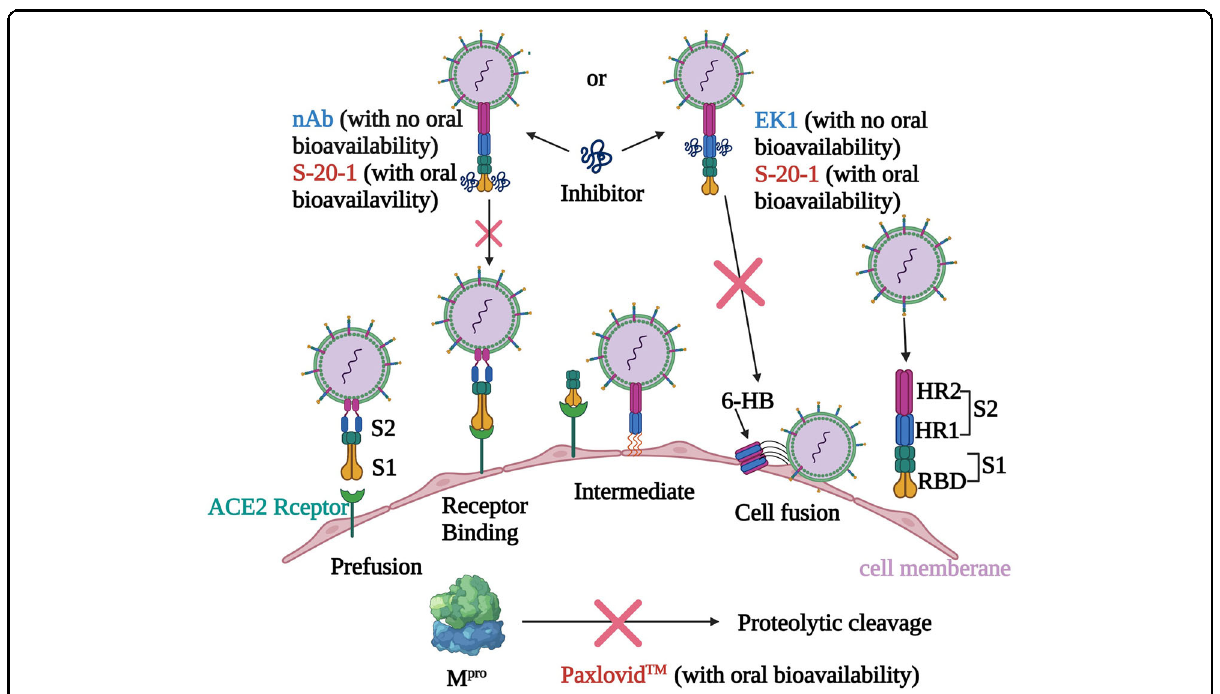
Fig. 10 Proposed mechanism of action of S-20-1 against SARS-CoV-2 infection. The entry of SARS-CoV-2 into the host cell is initiated by binding of RBD in S1 subunit of S protein to ACE2 (the receptor of SARS-CoV-2), which triggers the conformation change of S2 subunit of S protein and exposes the fusion intermediate structure consisting of HR1, HR2, and fusion peptide (FP). Then, HR1 and HR2 interact with each other to form 6-HB, bringing the viral and host cell membranes together for fusion. Like SARS-CoV-2 nAb and EK1 peptide, S-20-1 is able to bind with RBD in S1 subunit and HR1 in S2 subunit to block viral attachment and fusion, respectively. Different from nAb and EK1 peptide, S-20-1 also has oral bioavailability like Paxlovid ™ , noted above, which targets the intracellular main protease (M pro ). However, S-20-1 is superior to peptide- and lipopeptide-based pan-CoV fusion inhibitors because it is much more resistant to proteolytic enzymes and has a longer half-life than EK1, as well as good oral bioavailability. Therefore, S-20-1 has better potential to be developed as an orally usable drug for treatment of SARS-CoV infection. The fi gure was created with